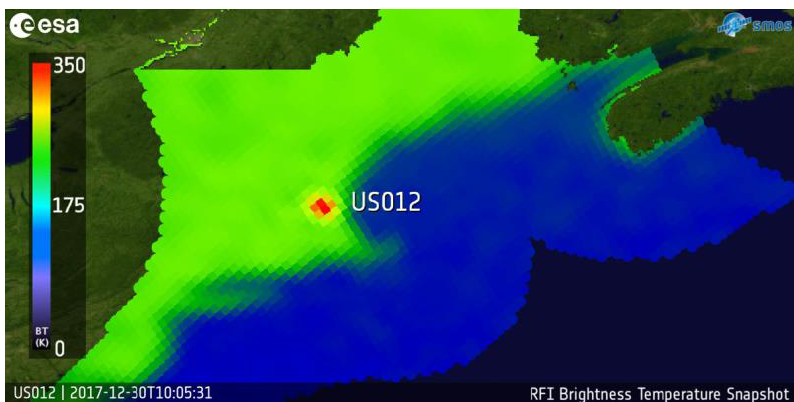
Figure 15. US012 source (TV amplifier) Brightness Temperature observation on 2017-12-31.